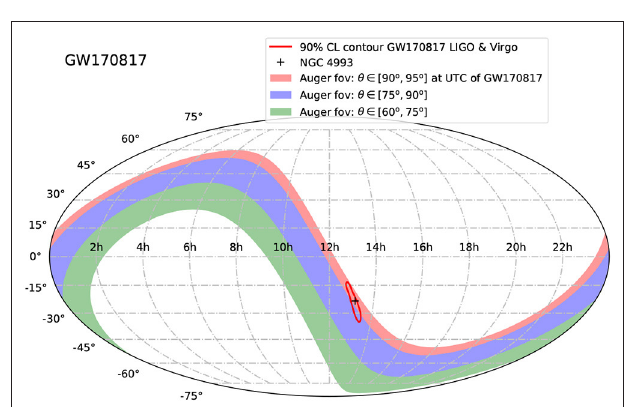
FIGURE 3 | Field of view of the Observatory in Earth-skimming and down-going channels at the instant of the detection of neutron star merger GW170817. The small red contour marks the event localization obtained by the Ligo-Virgo collaborations (LIGO-Collaboration, 2018) and the black cross is the position of NGC4993, later correlated to the event by optical telescopes (Coulter et al., 2017).